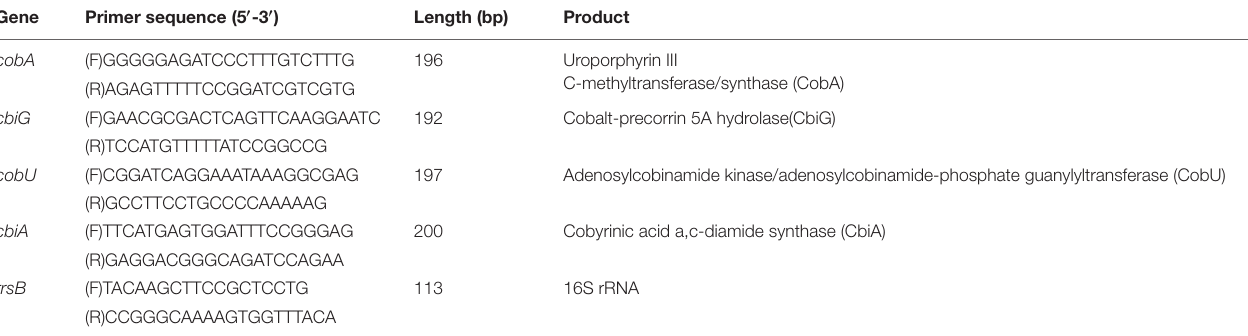
TABLE 1 | Primers used for RT-qPCR and qPCR reactions. Gene Primer sequence (5 (cid:48) -3 (cid:48) ) Length (bp)